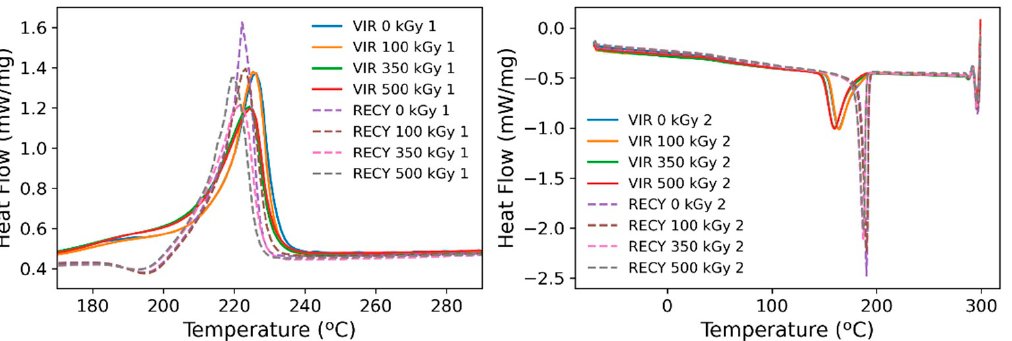
Figure 13. DSC Scans. Left: Melting peak for the first heating scan for both irradiated materials. Right: Crystallization peaks for both irradiated materials.